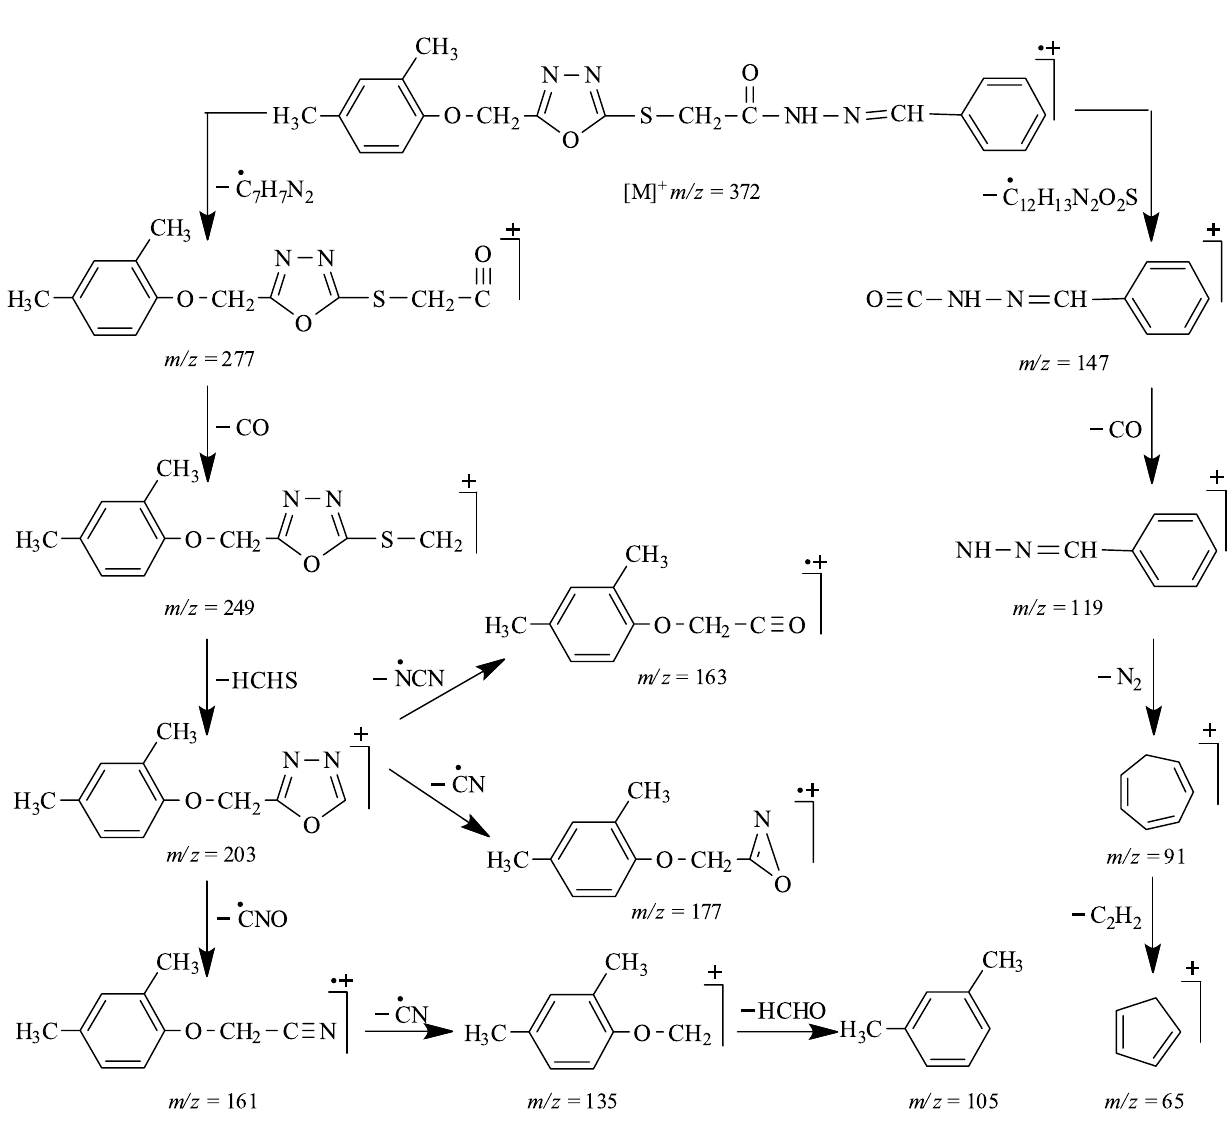
FIGURE 2 - Proposed mass fragmentation pattern of N’- benzylidene-2-(5-((2,4-dimethylphenoxy)methyl)-1,3,4-oxadiazol-2- ylthio)acetohydrazide ( 8a